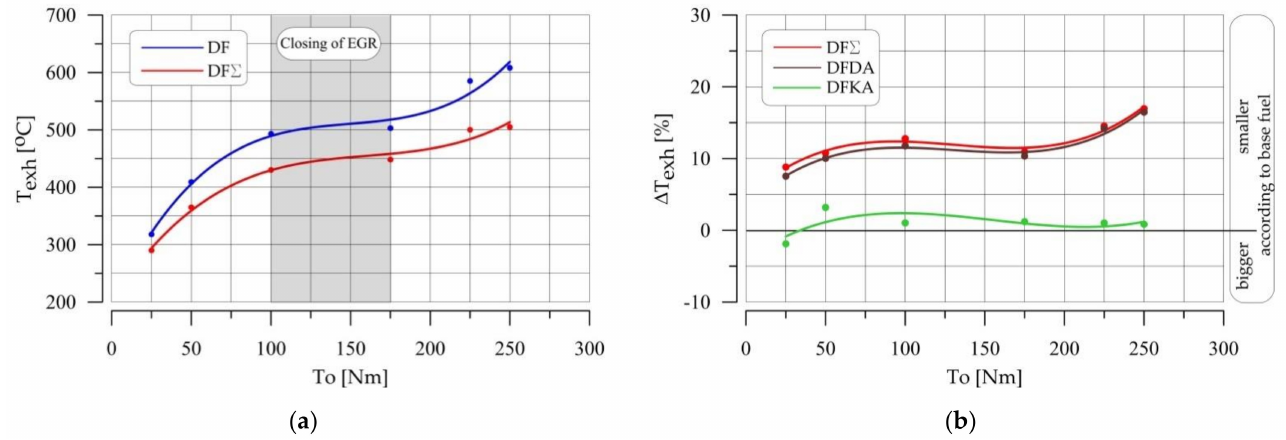
Figure 7. ( a ) Exhaust gas temperature vs. engine torque; ( b ) Percentage difference in exhaust gas temperature vs. engine torque in relation to the base